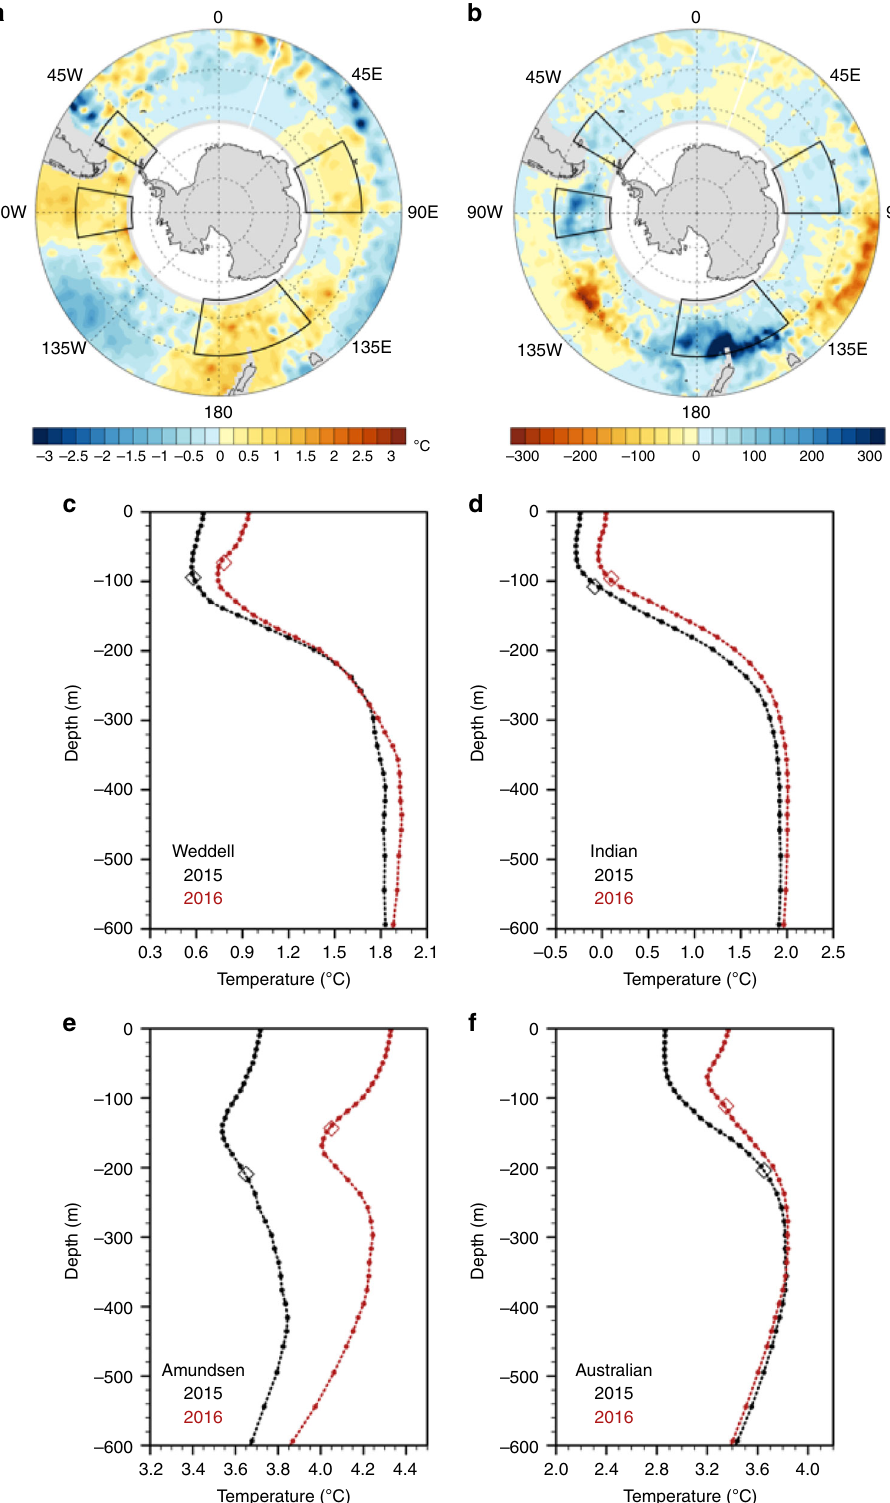
Fig. 3 Characteristics of the Southern Ocean in 2016 compared to 2015. a Gridded Argo fl oat 2.5m temperature differences (°C), SON 2016 minus SON 2015 33 ; b same as ( a ) except for mixed-layer depth anomalies (m); SON 2015 (black) and SON 2016 (red) vertical temperature pro fi les (°C) in the upper 600m and mixed-layer depth (diamonds) from the gridded Argo fl oat data averaged over the ( c ) Weddell region (50 – 65°S, 45 – 60°W), d Indian region (50 – 65°S, 60 – 90°E); e Amundsen region (50 – 65°S, 80 – 100°W); and f Australian region (50 – 65°S, 140°E – 170°W). The regions are denoted in ( a ) and ( b